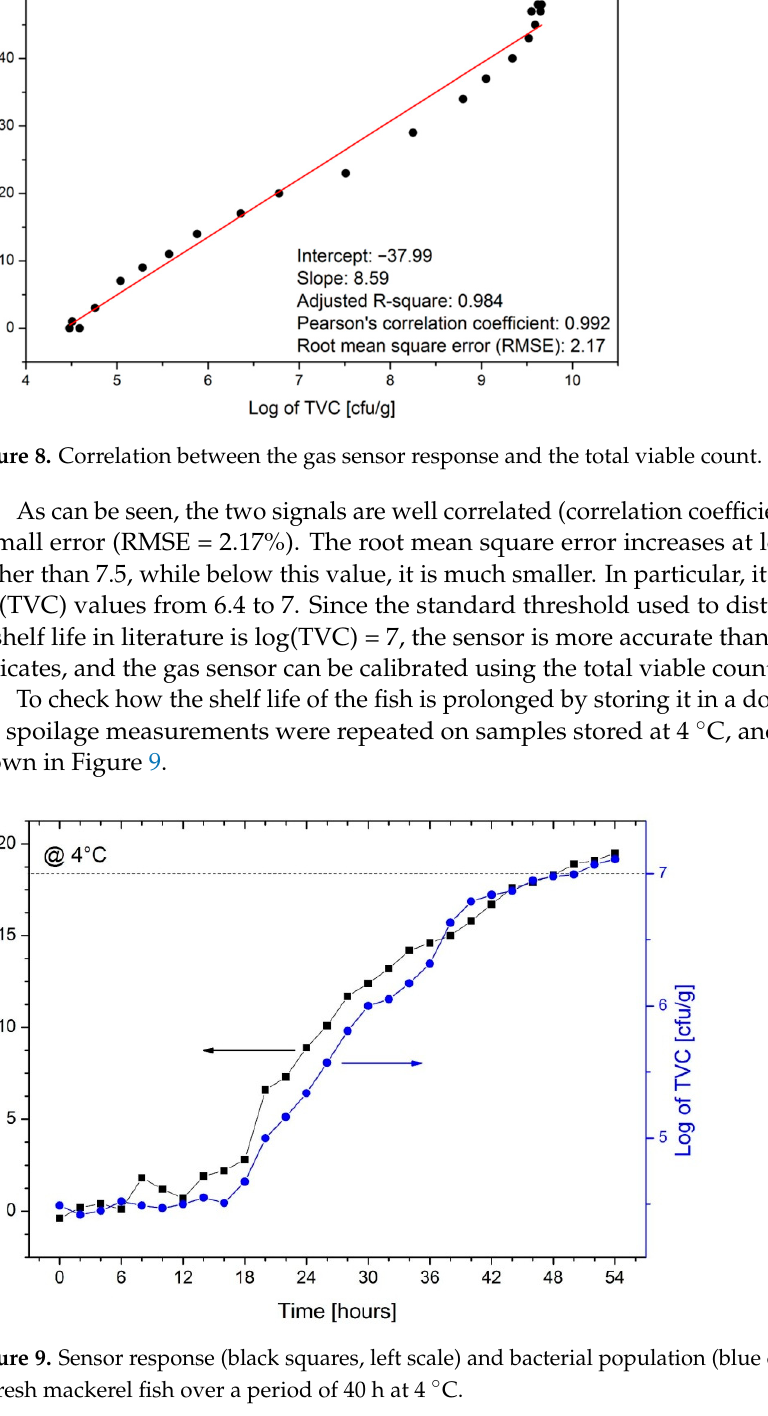
Figure 7. Sensor response (black squares, left scale) and bacterial population (blue circles, right scale) in fresh mackerel fish over a period of 40 h at room temperature (25 °C).